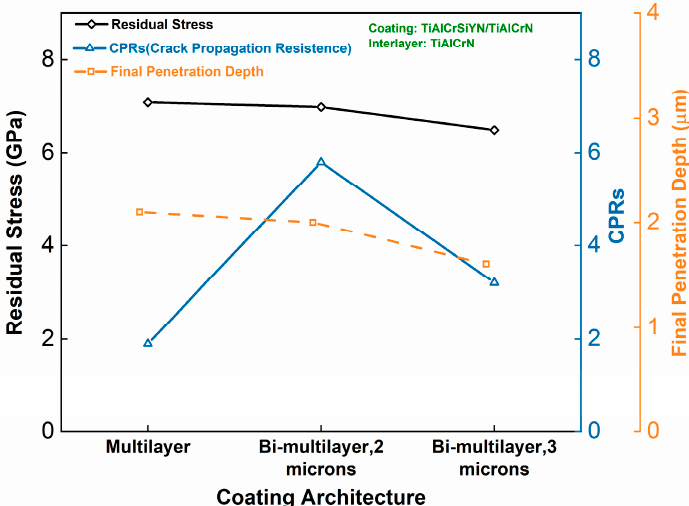
Figure 1. Comparison of micro-mechanical properties of a TiAlCrSiYN/TiAlCrN multilayer coating with a TiAlCrN interlayer [23] .